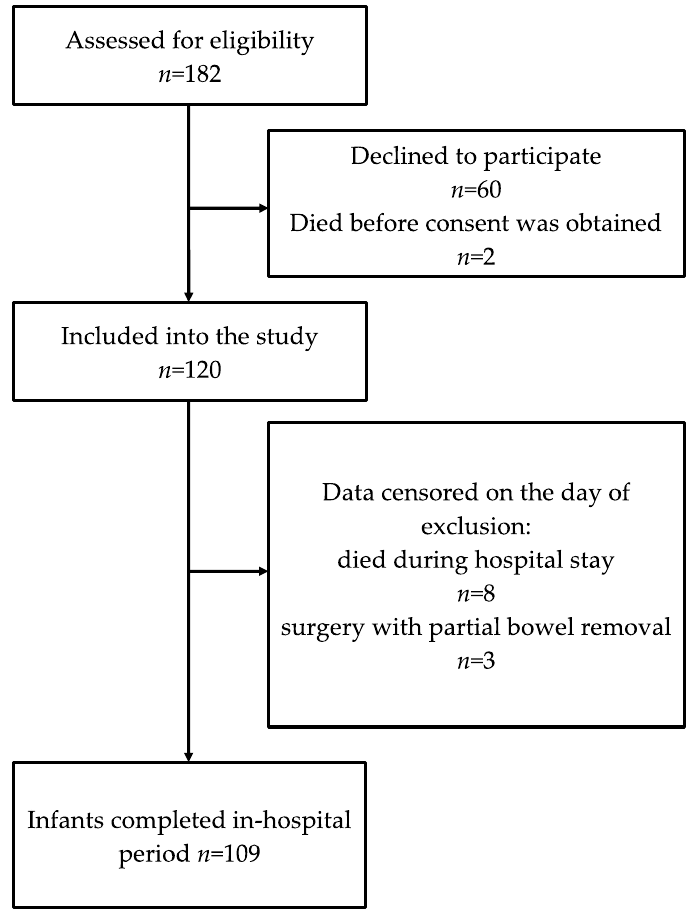
Figure 1. Flowchart of the study subjects’ inclusion.